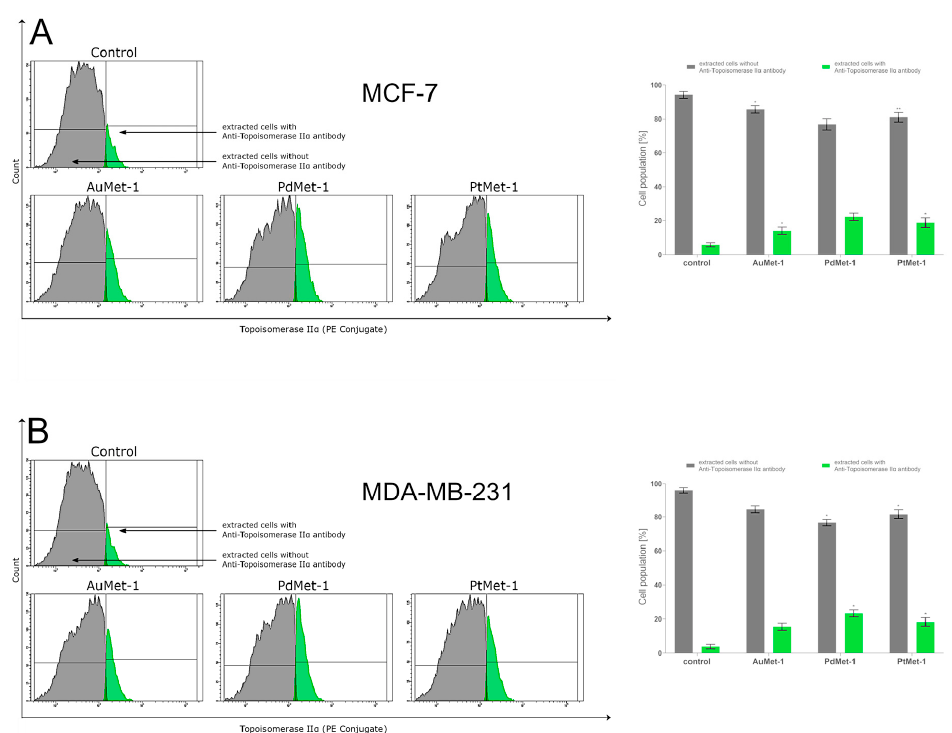
Figure 6. Anti-topoisomerase II α Antibody flow cytometric analysis of MCF-7 ( A ) and MDA-MB-231 breast cancer cells ( B ) (right histogram- green color) compared to a negative control cell (left histogram- gray color) after 24 h of incubation with AuMet-1, PdMet-1, PtMet-1 and cisplatin (50 µ M). Mean percentage values from 3 independent experiments (n = 3) done in duplicate are presented. * p < 0.05 vs. control group, ** p < 0.01 vs. control group.